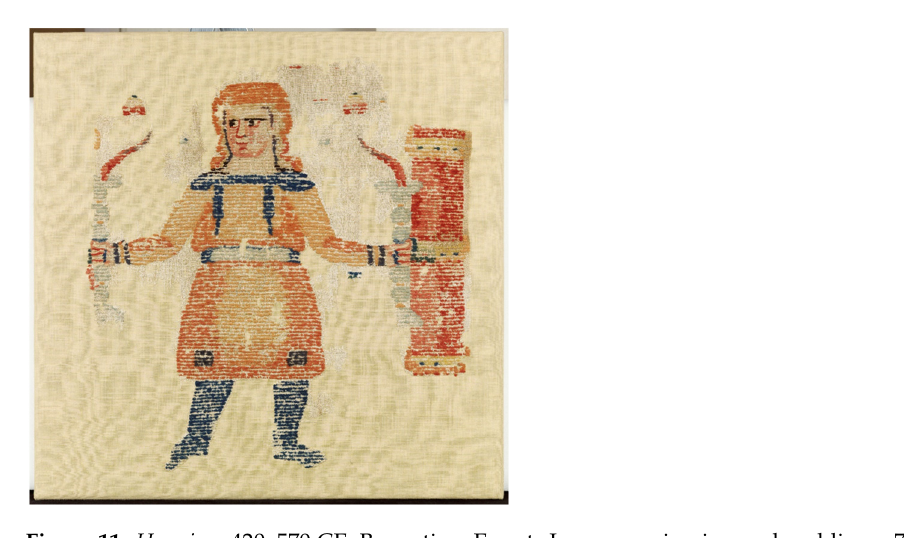
Figure 10. Fragment of a curtain , 4th–6th century CE. Late Roman. Linen plain weave with poly- chromy wool weft pile loops; 97.5 × 131 cm (38 3/8 × 51 9/16 in.). Museum of Fine Arts, Boston, Charles Potter Kling Fund, 49.313. Photograph © [2022] Museum of Fine Arts, Boston.